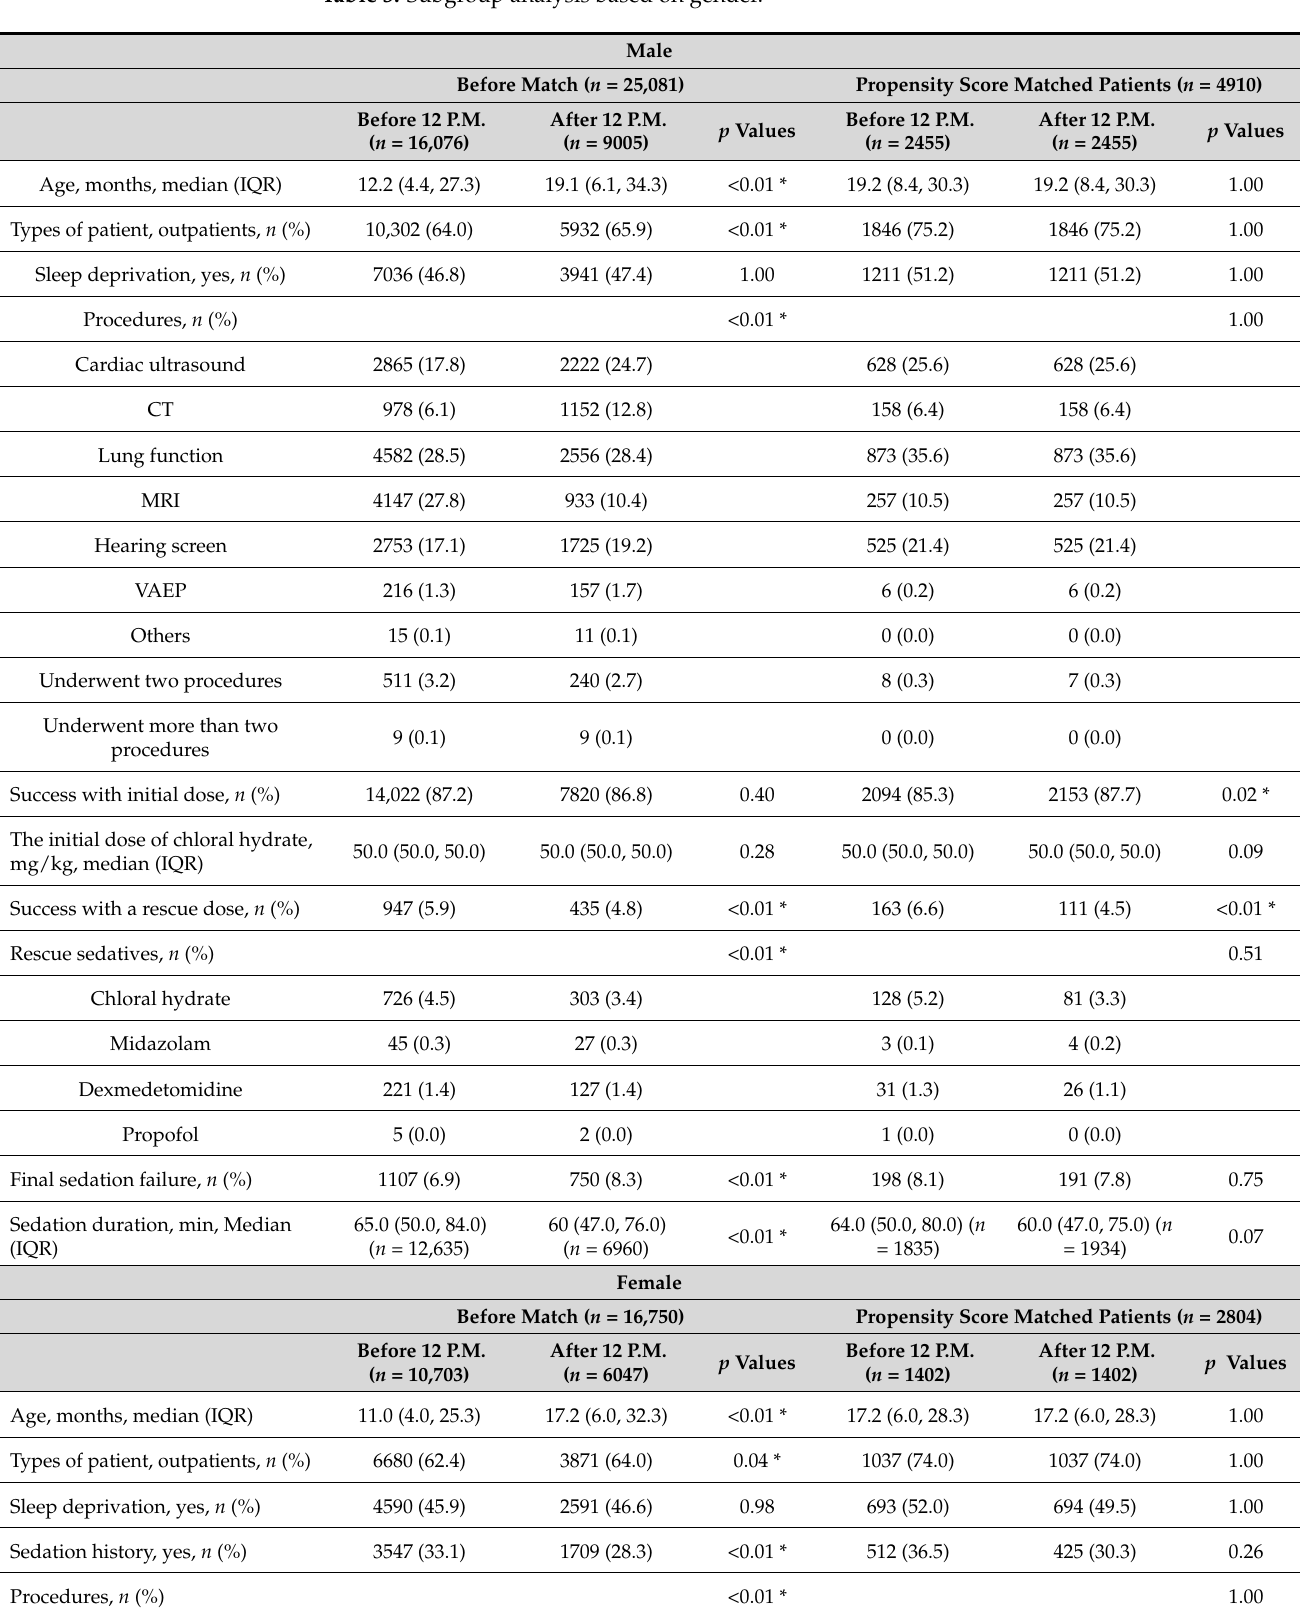
Table 3. Subgroup analysis based on